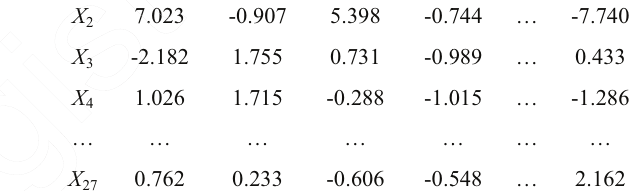
Fig.3 gives BP diagnosing model’s le the abscissa for learning times coordinate for training error. The res for the first 700 times in the learn training error decreases fast, and th meets the requirements of target error Plus, since the initial weight betwe generated randomly, given the same n network parameters and the same trai result of the training (including the we of the model, learning curve, etc) i identical.